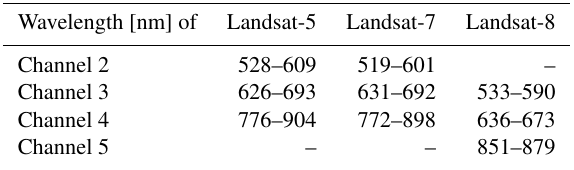
Table 2. Overview about the wavelengths and bandwidths of the Landsat channels